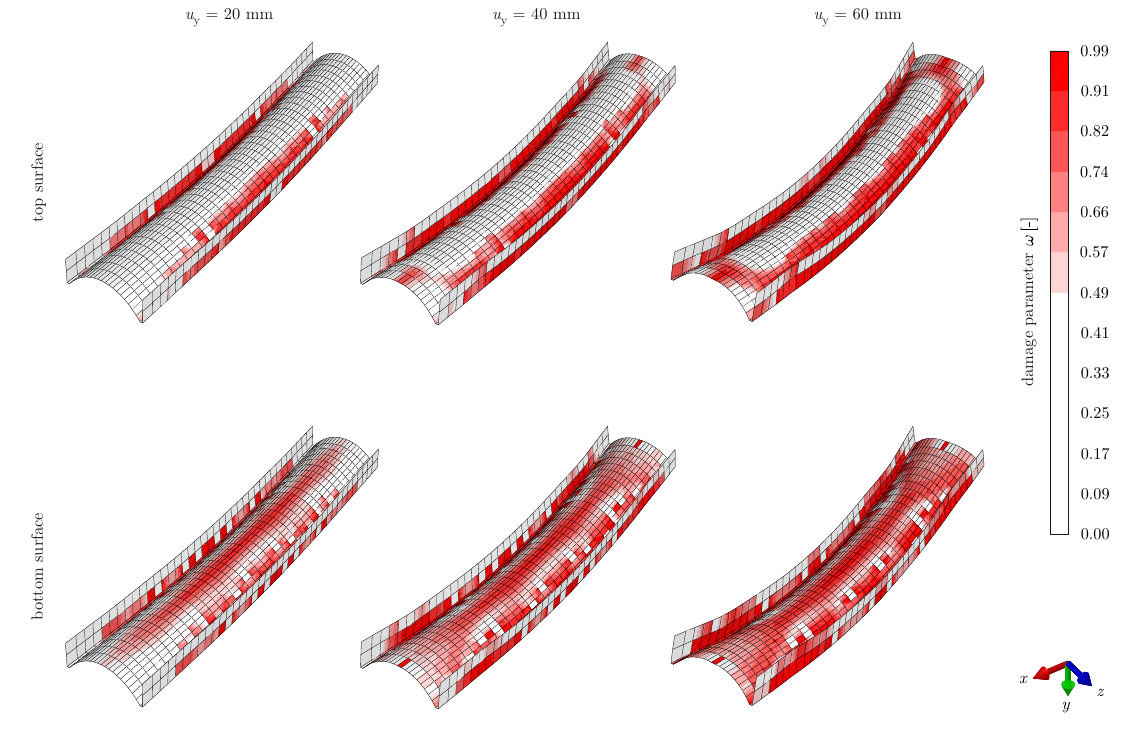
Figure 22. Damage propagation in the surface of the girder for top and bottom